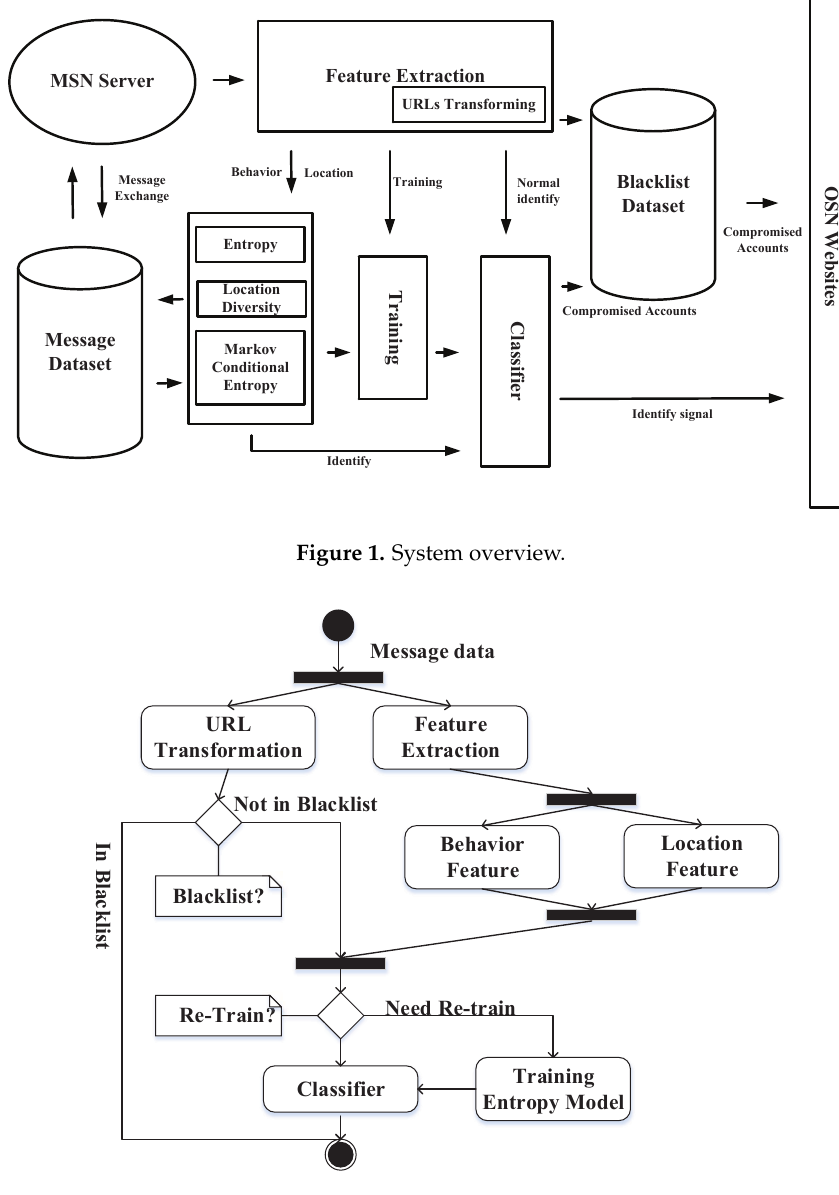
Figure 2. Activities of message